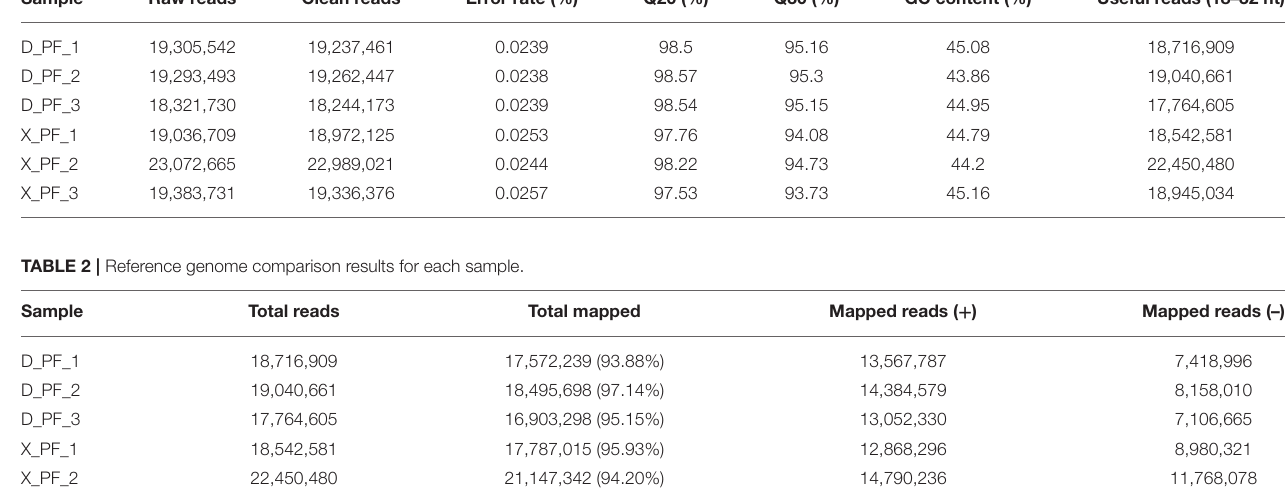
TABLE 1 | Quality control statistics of sequencing data for each sample. Sample